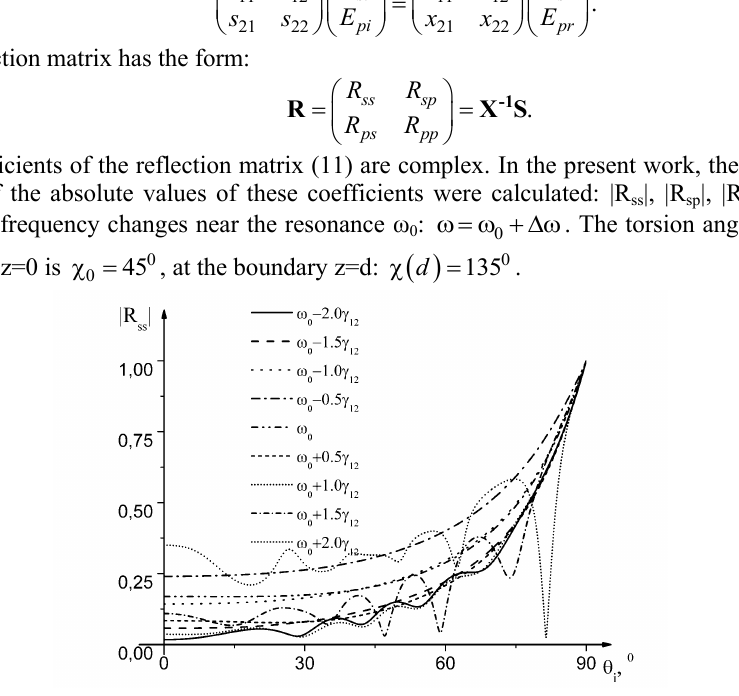
Fig. 2 . Angular dependence of the modulus of the amplitude reflection coefficient R ss in the vicinity of the resonant